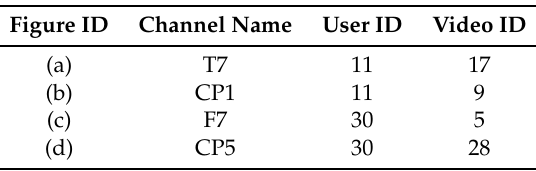
Figure 4. The waveforms for random subjects and different channels: ( a ) 11-T7 ( b ) 11-CP1, ( c ) 30-F7 ( d ) 30-CP5. Table 2. Channel allocation distribution to Figure